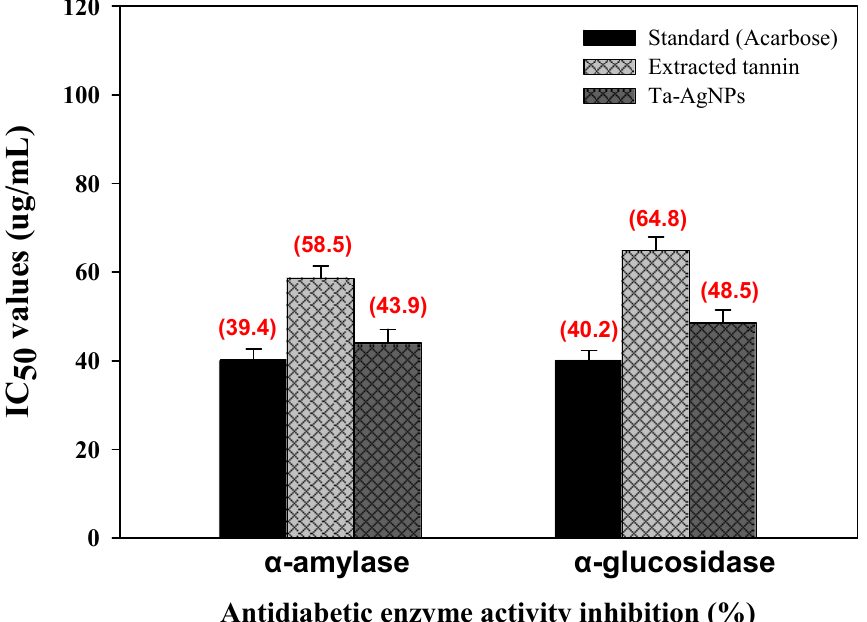
Figure 9. Antidiabetic potential of synthesized Ta-AgNPs, extracted tannin, and standard (acarbose) against α -amylase and α -glucosidase and their IC 50 values.